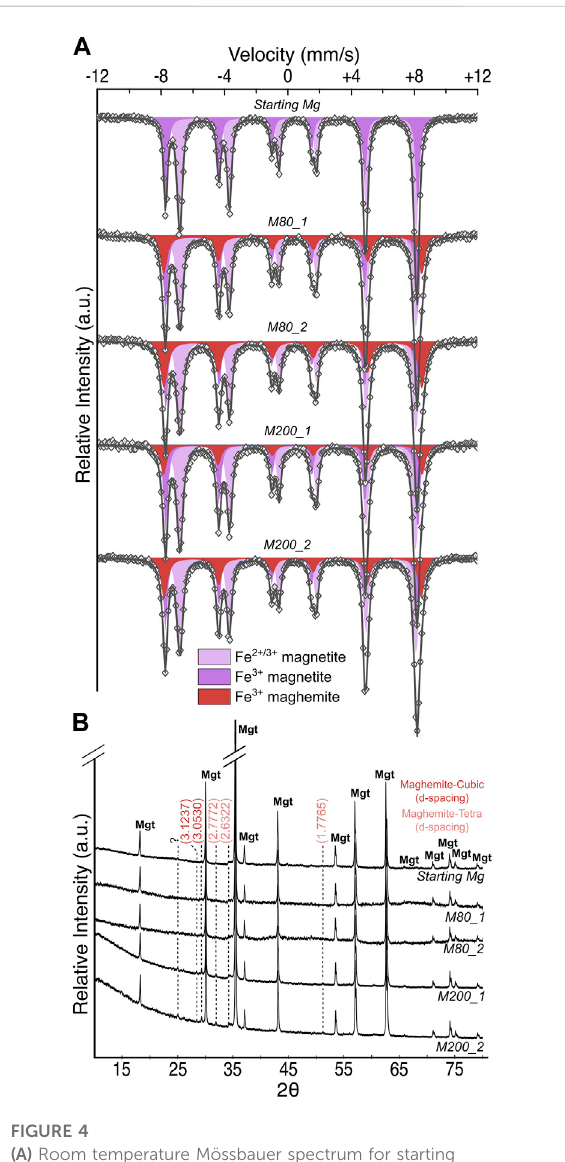
(A) Room temperature Mössbauer spectrum for starting magnetite and solid products from M200_1, M200_2, M80_1, and M80_2. For quantitative results, see Table 2. (B) XRD results for the same powders. Mgt refers to the peaks previously correlated to